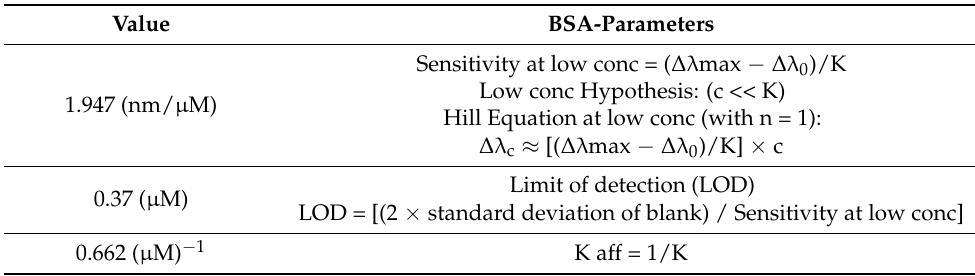
Table 2. Chemical parameters for bovine serum albumin (BSA)